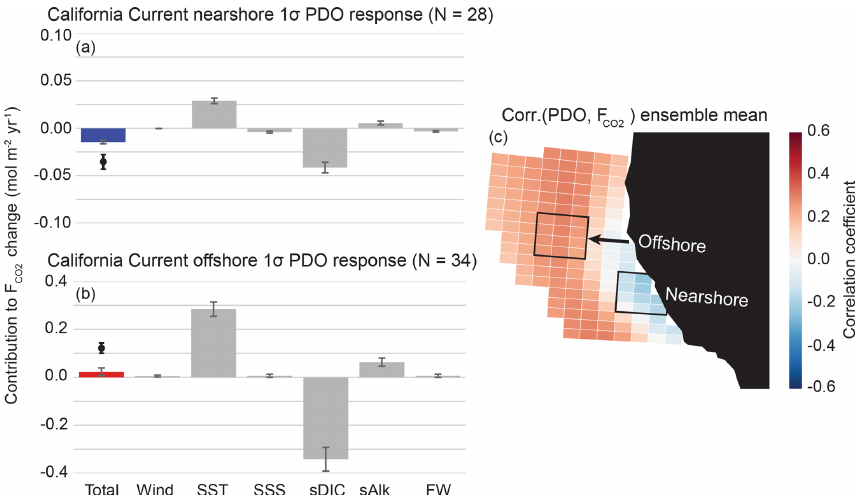
Figure 7. As in Fig. 6, but in response to the PDO for a nearshore region (a) and offshore region (b) . Note that the offshore decomposition (b) has a y -axis range 4 times that of the nearshore decomposition (a)